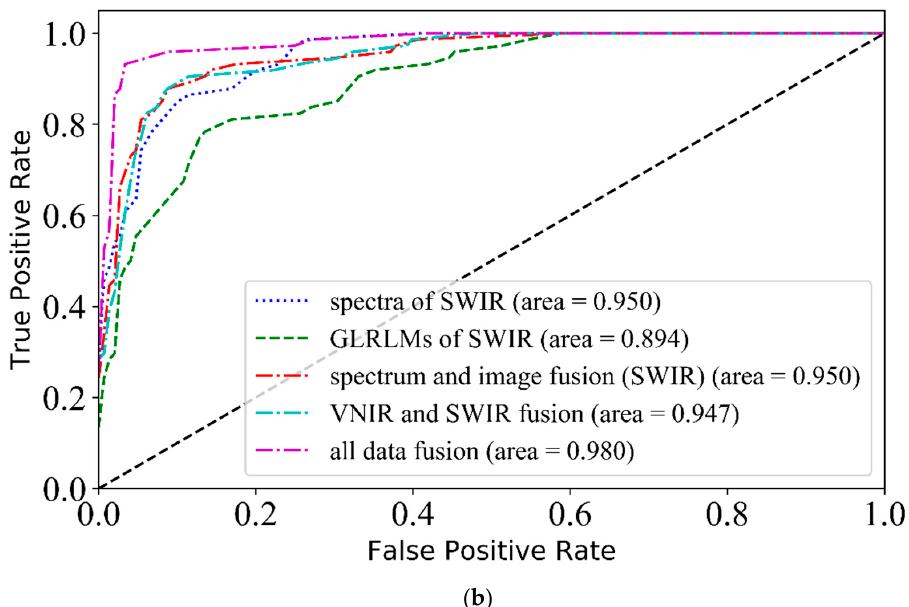
Figure 7. The ROC curves of three fusion methods, SPA band spectra, and images in the VNIR range ( a ) and the SWIR range ( b ) based on the prediction set. Sensors 2019 , 19 , x